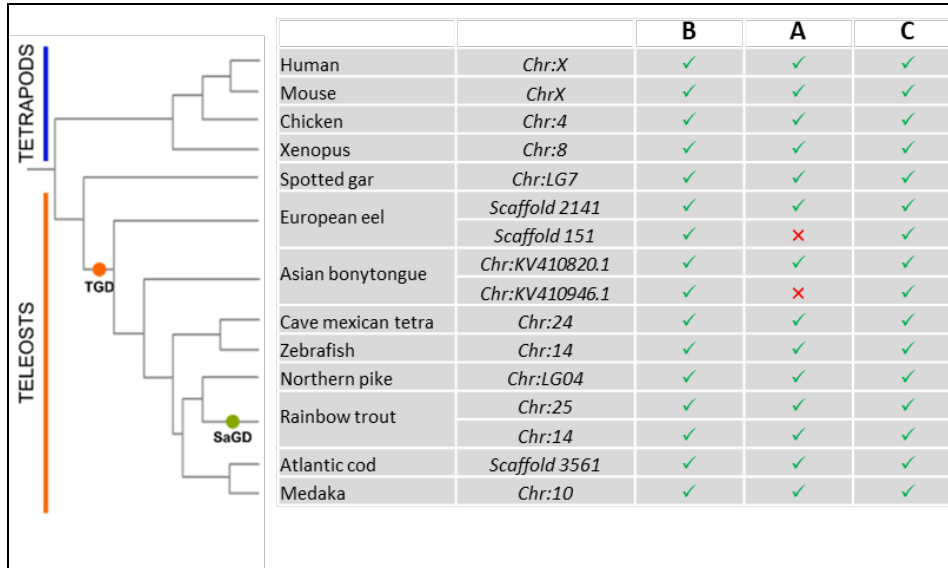
Figure 5. Presence of the three alternative exons ( B , A , and C ) in the LAMP2 gene in four tetrapod species—human ( H. sapiens ), mouse ( M. musculus ), chicken ( G. gallus ), and frog ( X. tropicalis )—and nine fish species—spotted gar ( L. oculatus ), European eel ( A. anguilla ), Asian bonytongue ( S. formosus ), cave Mexican tetra ( A. mexicanus ), zebrafish ( D. rerio ), Northern pike ( E. lucius ), rainbow trout ( O. mykiss ), Atlantic cod ( G. morhua ), and medaka ( O. latipes ). The phylogenetic tree is a representative tree of life. The presence or absence of each alternative exon ( B , A , and C ) is represented by a green check mark or a red cross mark, respectively. For each species, the location of the gene is specified in the table. TGD, teleost-specific whole-genome duplication; SaGD, salmonid-specific whole-genome duplication.